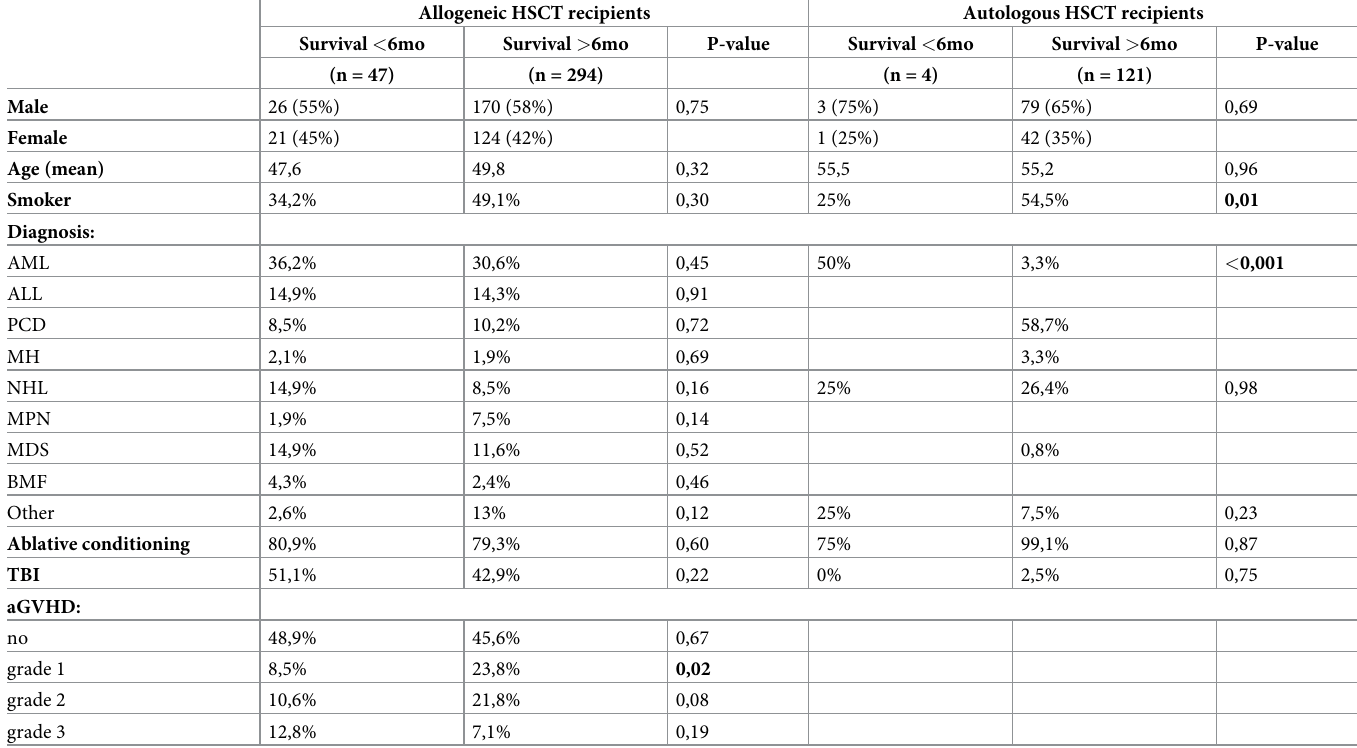
Table 1. Descriptives of the disease and transplant-related factors of the allogeneic and autologous HSCT recipients.